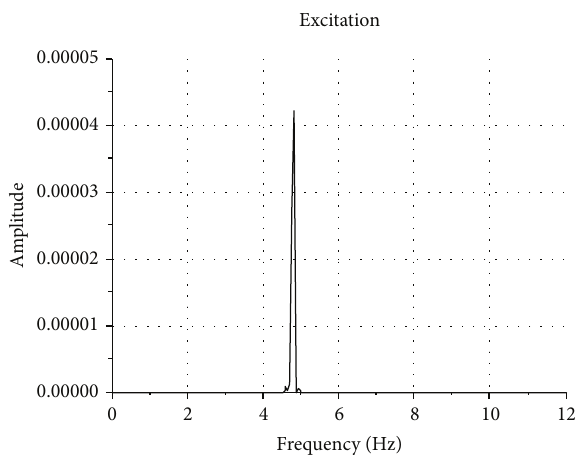
Figure 11: Power density spectrum of the acceleration response of the model for sine